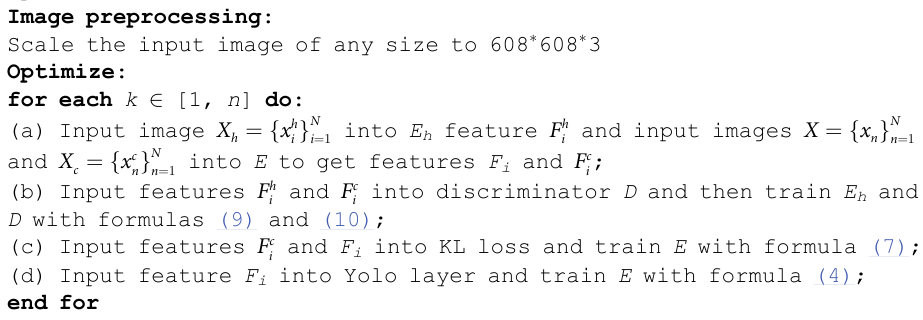
Algorithm 1 the proposed